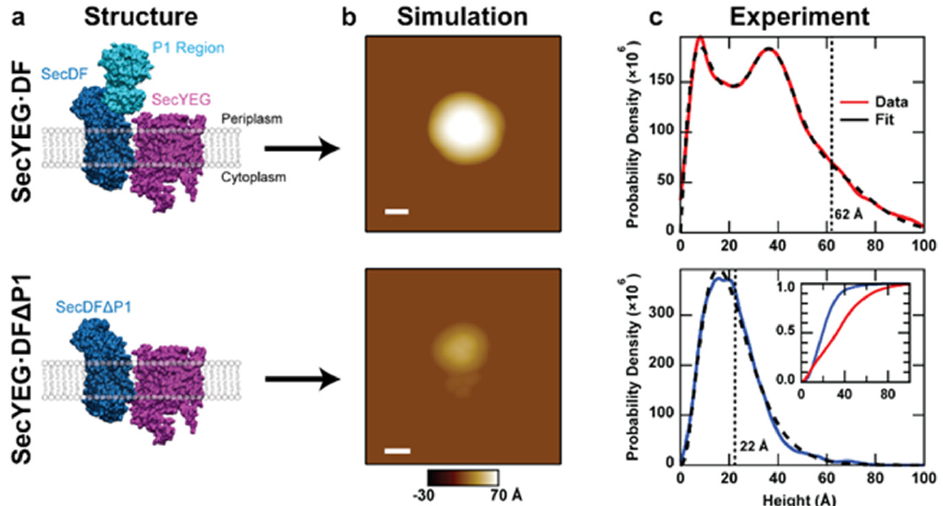
Figure 7. Analysis of co-assembled SecYEG·SecDF ∆ P1. ( a ) Models of wild-type and mutant SecDF co-assembled with SecYEG (structures manually oriented from 5MG3). Here, SecDF is shown in the intermediate (I) form in which the P1 domain is oriented upward. ( b ) Simulated AFM images of the periplasmic side of the structures are shown in ( a ). The lateral scale bar is 50 Å, and the pixel spacing is 4 Å. Note tip convolution obscures SecYEG from view in the case of the wild-type complex. ( c ) Height histogram and fit of AFM data consisting of individual SecYEG · SecDF molecules protruding from supported lipid bilayers. Both wild-type ( N = 10,118) and ∆ P1 mutant ( N = 1088) samples were analyzed. Dashed vertical lines represent simulated maximum heights from (b). ( c , inset) Integration of the wild type (red) and mutant (blue) histograms show the accumulated fraction. Data adapted from Ref. [40] .